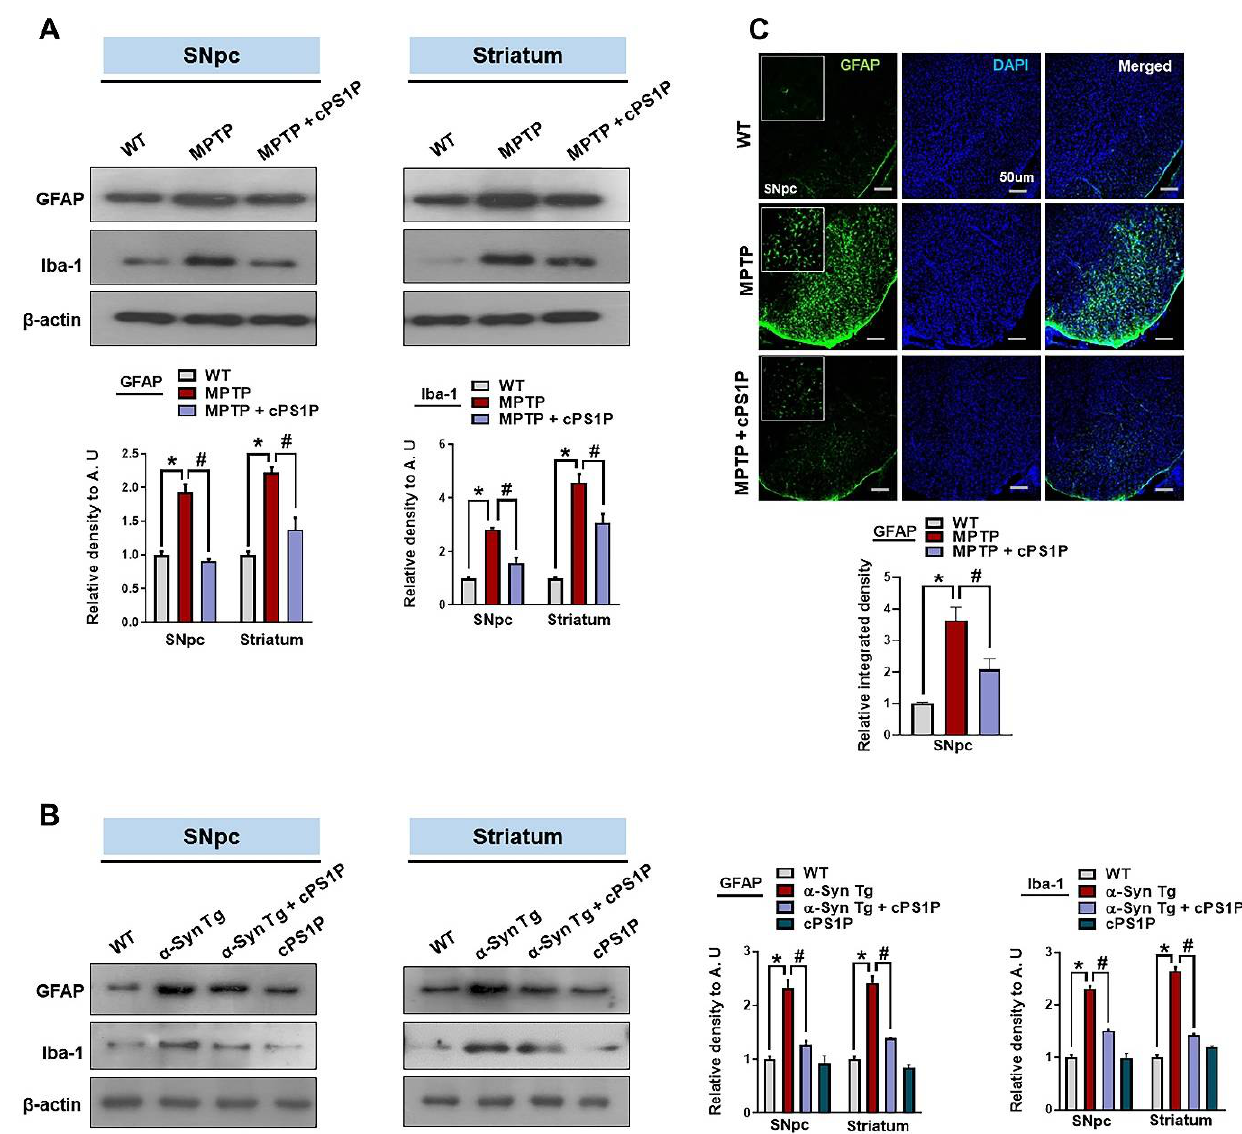
Figure 6. cPS1P treatment ameliorated PD-induced activation of glial cells. ( A ) Western blot analysis of GFAP and Iba-1 in the substantia nigra pars compacta (SNpc) and striatum of MPTP PD mouse model (n = 5 mice/group). ( B ) Western blot analysis of GFAP and Iba-1 in the SNpc and striatum of NSE-h α Syn PD mouse model (n = 5 mice/group). ( C ) Immunofluorescence reactivity of GFAP